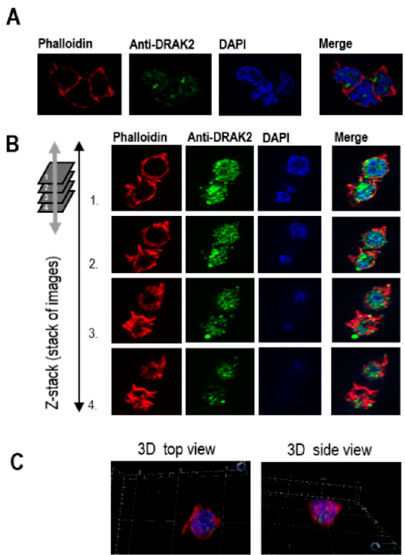
Figure 3. Immunofluorescence analyses of DRAK2 cellular localization in MEC-1 cells. MEC-1 cells were stained with different fluorophores to visualize cellular compartments: cytoplasm/actin filaments (visualized with phalloidin) and nucleus (visualized with DAPI). Cells were analyzed using a ZEISS Axio Imager microscope. Z1 to generate 2D view ( A ) using ZEISS Apotome that allows the collection of confocal-like “Z” stacks to project images, as shown in 3D ( B , C ).